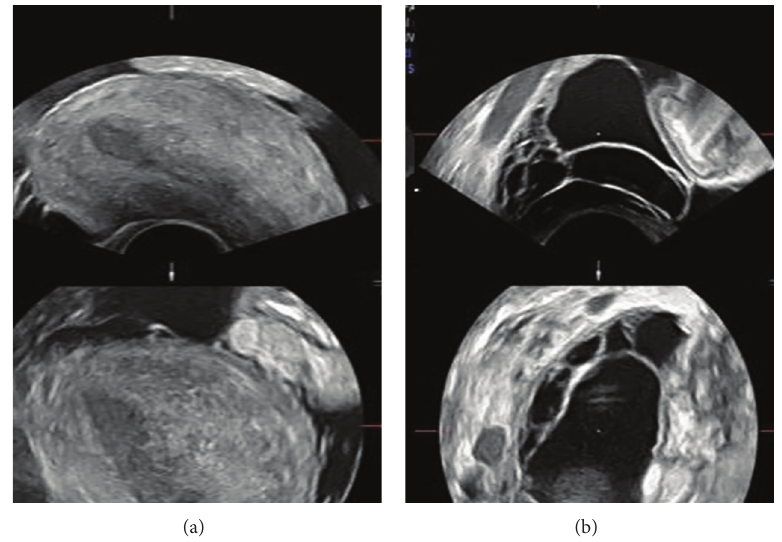
Figure 1: Transvaginal ultrasonography: (a) uterus and ascites; (b)